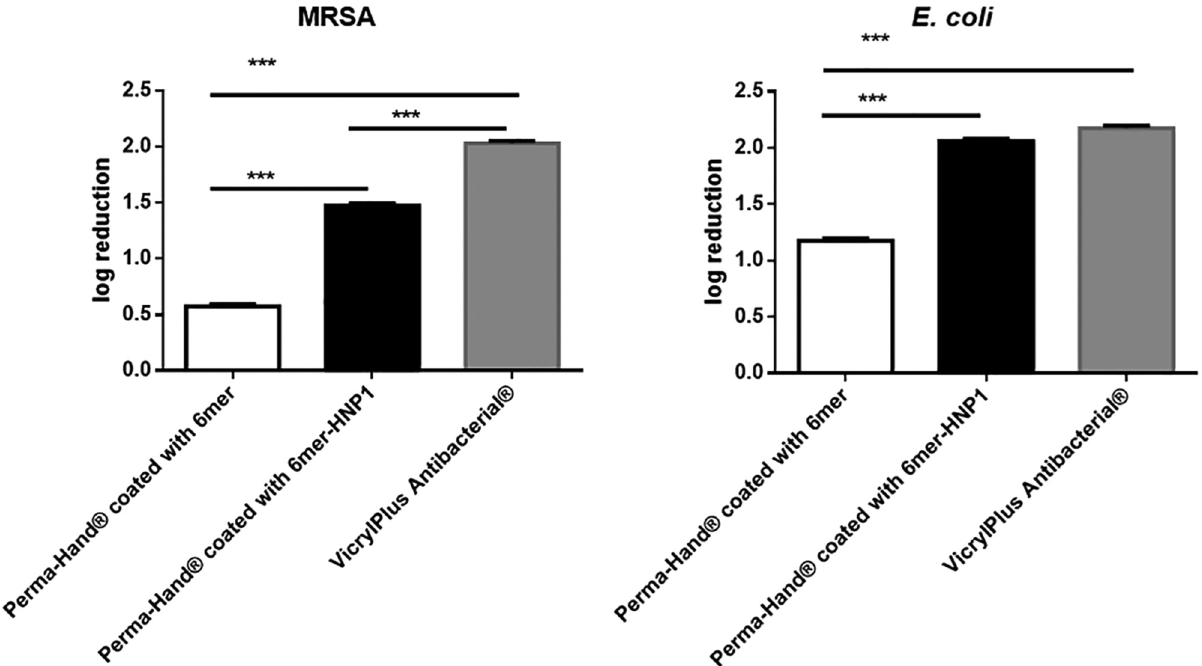
Figure 5: Comparison of the e ff ects of Perma - Hand sutures with 6mer and 6mer - HNP1 coating on Staphylococcus ( MRSA ) and E. coli at 37°C ( 79 ) . Copyright 2019,